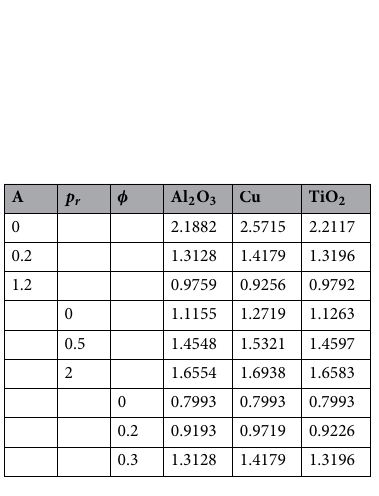
Table 3. Variation of Skin friction for water-based